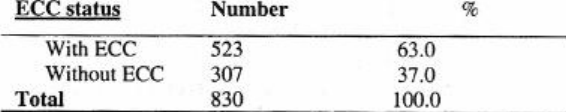
Table 2. Prevalence of ECC among study